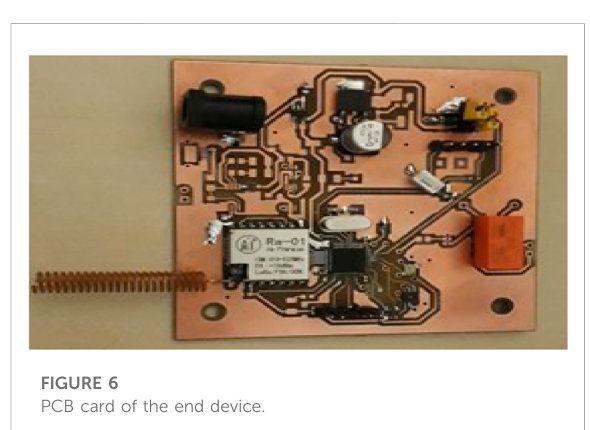
FIGURE 6 PCB card of the end